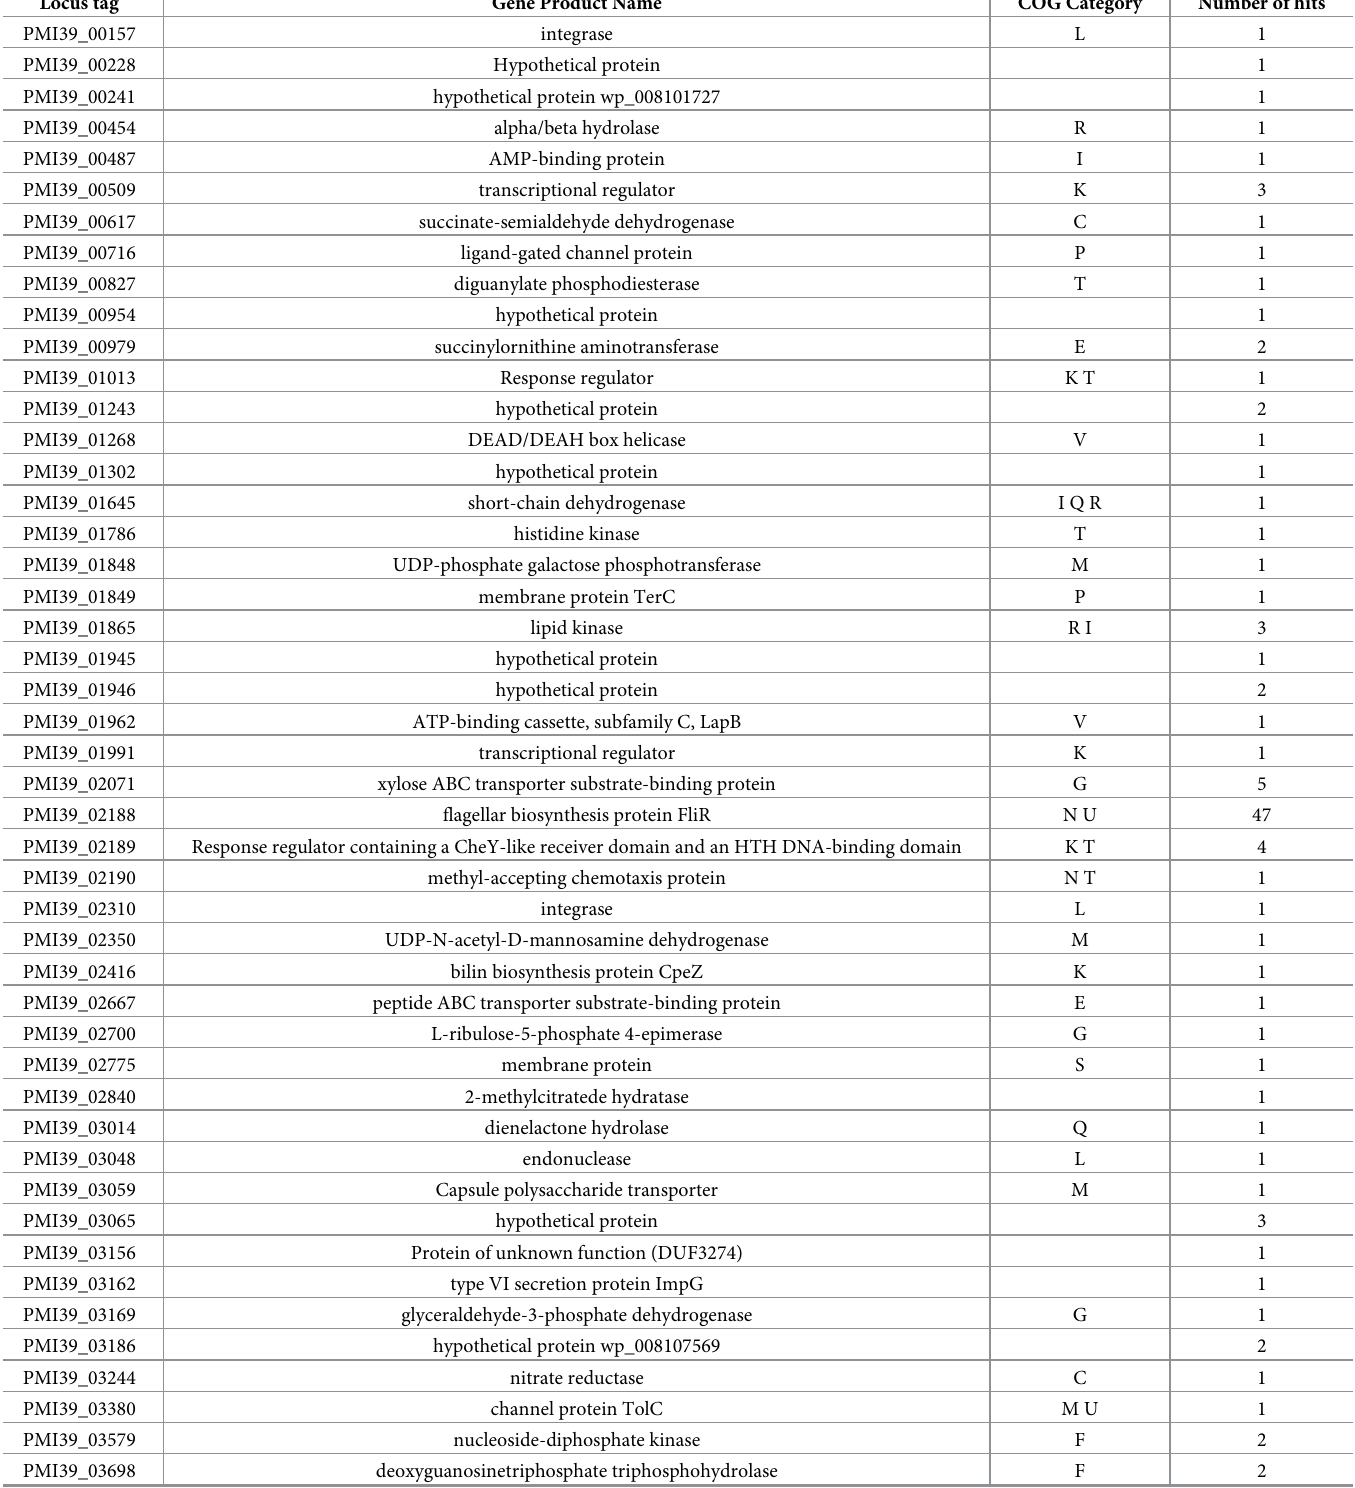
Table 3. List of genes identified by transposon mutagenesis. Locus